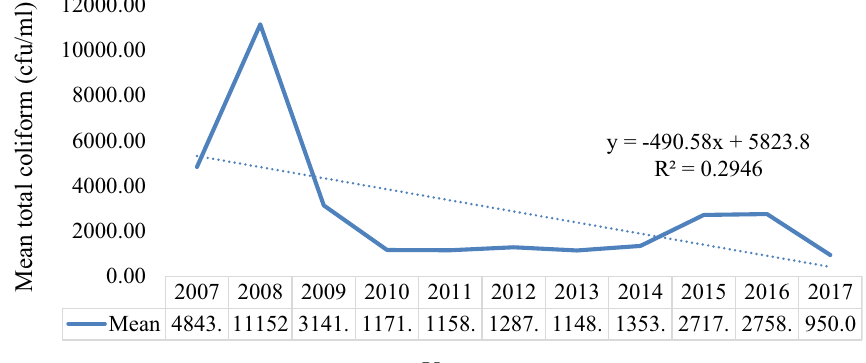
Fig. 4 Annual temporal variation of total coliform in the Nawuni Catchment